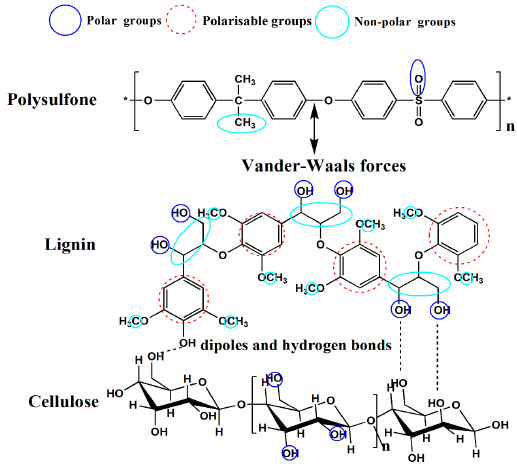
Figure 1. The absorption promoter mechanism of lignin on cellulose adhesion to the membrane matrix.